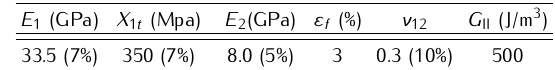
Table 1. Material properties 0/90 lay-up for Kevlar/Epoxy composite.